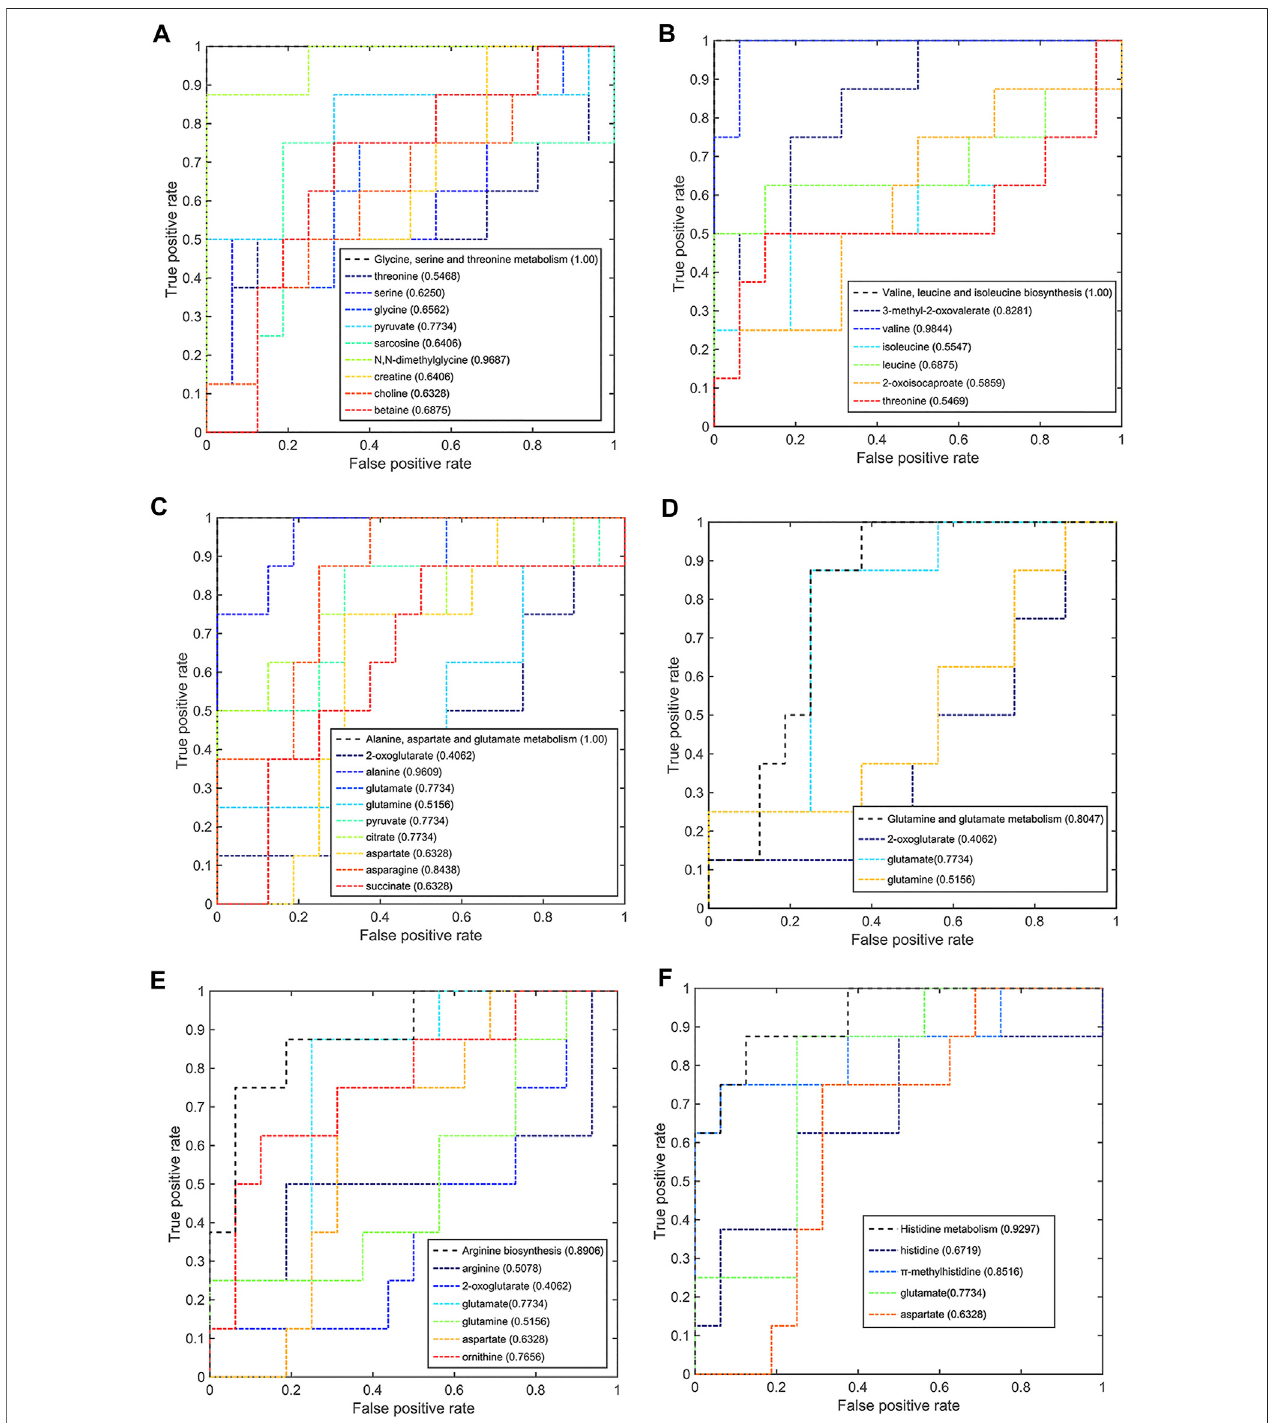
FIGURE 7 | Multi-ROC curves assessing discriminant capabilities of the signi fi cantly disturbed metabolic pathways in the pCR patients compared with the pSD patients. The AUC values shown in brackets are used to evaluate the performances of various biomarker models: (A) glycine, serine, and threonine metabolism; (B) valine, leucine, and isoleucine biosynthesis; (C) alanine, aspartate, and glutamate metabolism; (D) glutamine and glutamate metabolism; (E) arginine biosynthesis; (F) histidine metabolism.